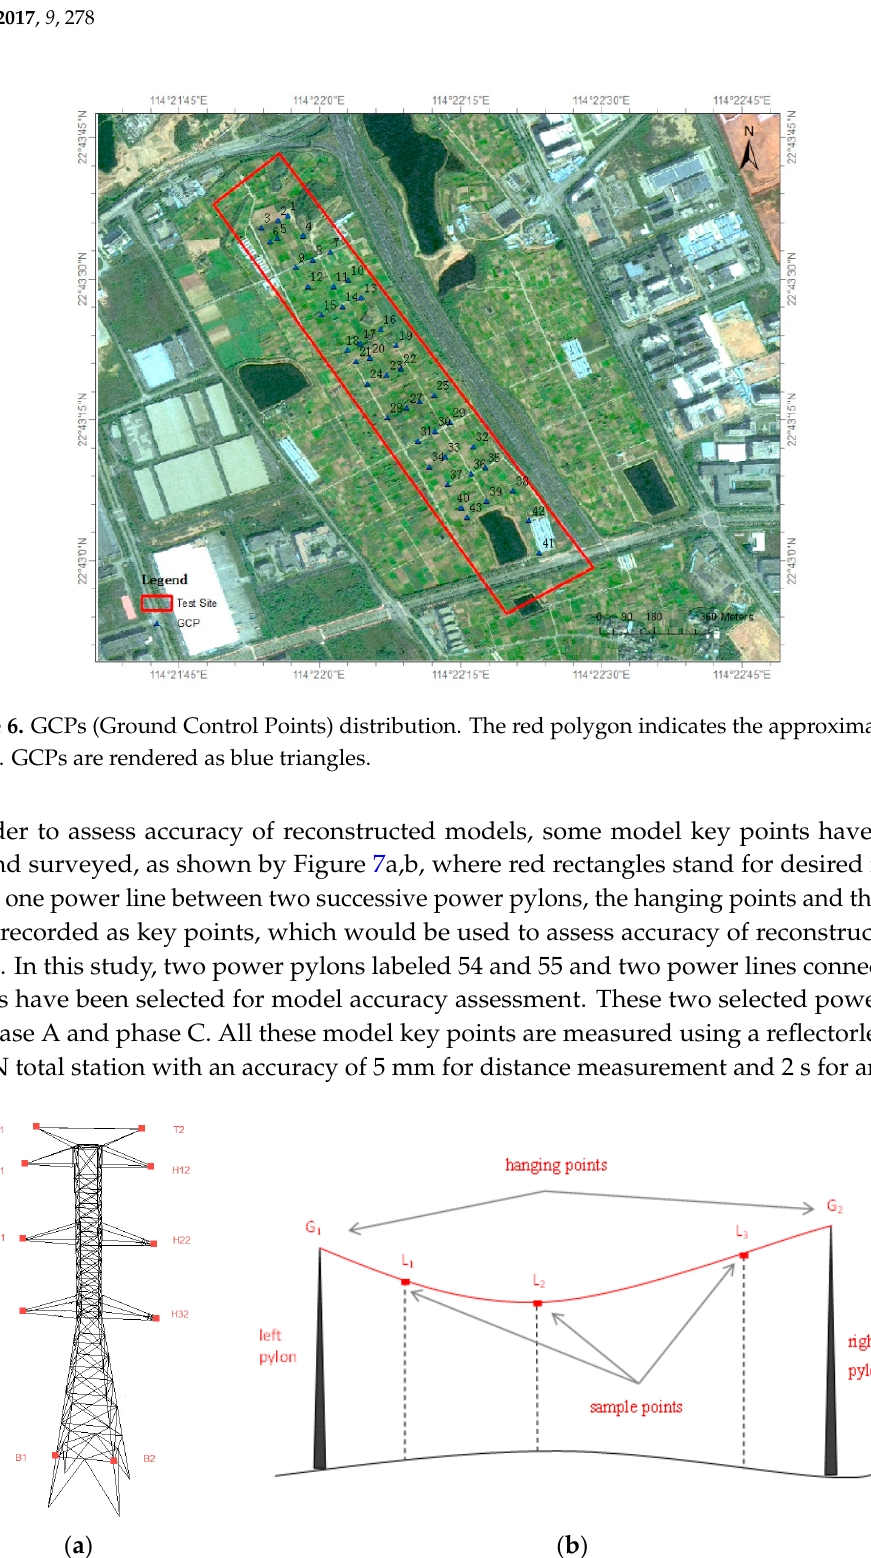
( d ) Figure 5. Images taken in test site: ( a , b ) taken by front camera in direction of along-track; and ( c , d ) taken by back camera in direction of across-track. 3.1.2. GCP and Key Point Survey Ground control points make it possible to achieve the best geo-referencing accuracy for image orientation. Comparison between ground true coordinates and measured model coordinates could be used to assess accuracy of reconstructed models. Usually, ground control points are focused on obvious feature points which could be easily identified and measured in photographs, such as road intersections and building corners. Considering that four roads go across the whole test site and many water pools exist with nearly right angles, 43 ground control points have been selected on these two types of regions, which are uniformly distributed in test site as shown by Figure 6. The accurate coordinate measurements are performed with a Trimble R8 GNSS receiver, whose horizontal and vertical accuracies are 1 and 2 cm in RTK-GNSS mode, respectively. Meanwhile, the CORS system named GDCORS has been used, which has five CORS base stations in the city of Shenzhen and could provide geo-referencing services with centimeter-level precision. In order to assess accuracy of reconstructed models, some model key points have also been selected and surveyed, as shown by Figure 7a,b, where red rectangles stand for desired model key points. For one power line between two successive power pylons, the hanging points and three sample points are recorded as key points, which would be used to assess accuracy of reconstructed